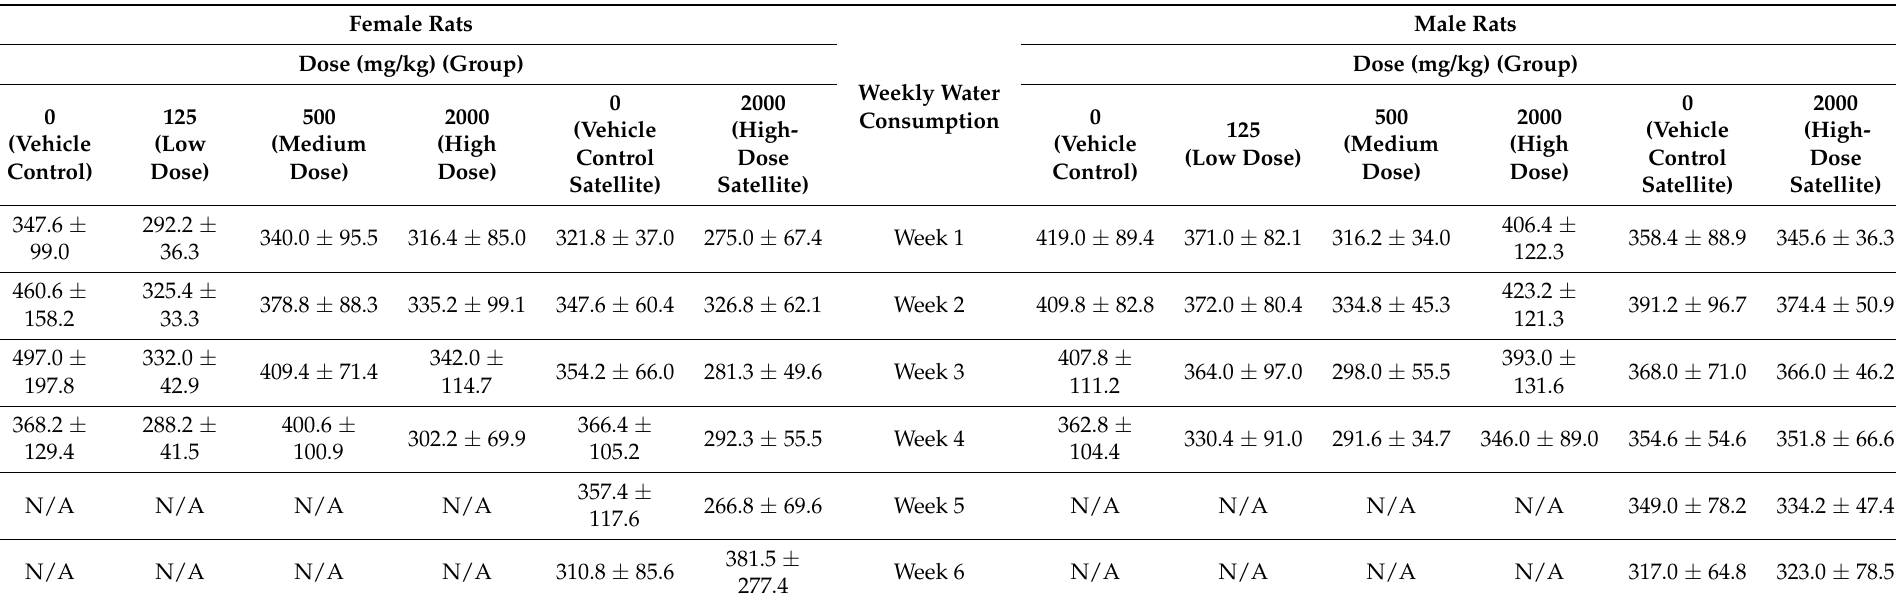
Table 5. Mean water consumption (g) in female and male